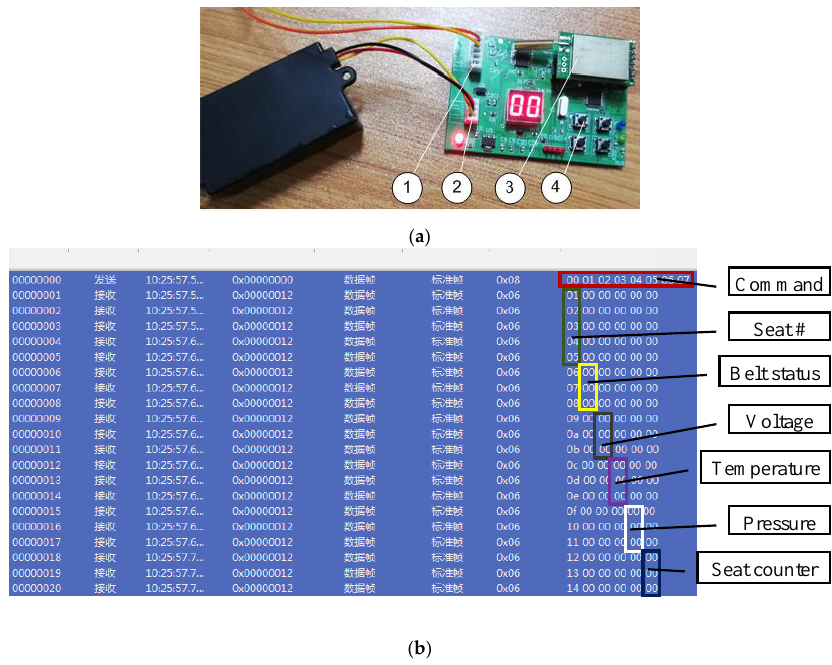
Figure 11. ( a ) The developed concentrator system: (1) controller area network (CAN) output, (2) power supply input, (3) 433 MHz wireless module, (4) registration keys. ( b ) The initial monitoring interface, where the data will come from the concentrator’s CAN output